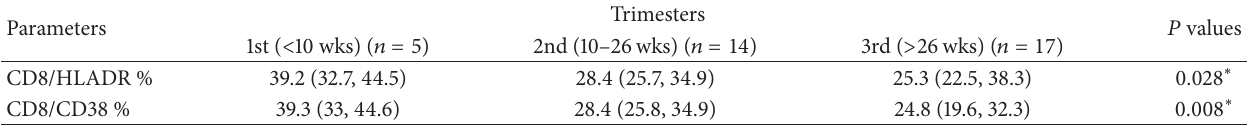
Table 3: Activated CD8T cell counts in the pregnant group in different trimesters (data are median (interquartile